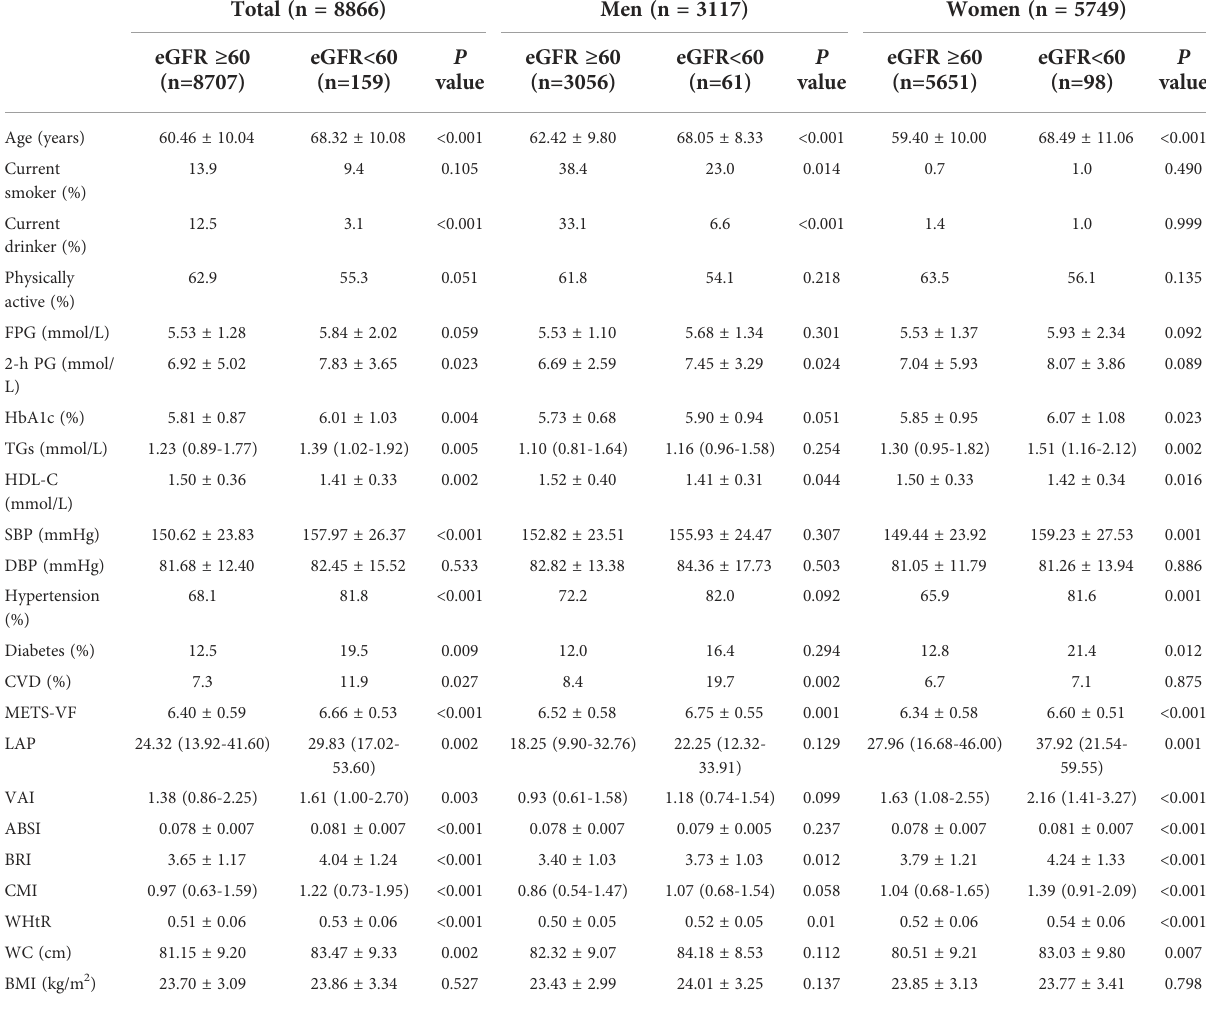
TABLE 1 Participant characteristics of CKD and non-CKD